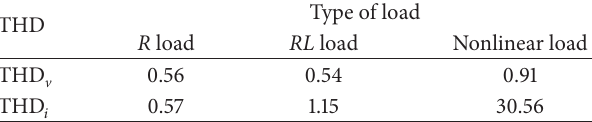
Table 2: THD comparison.